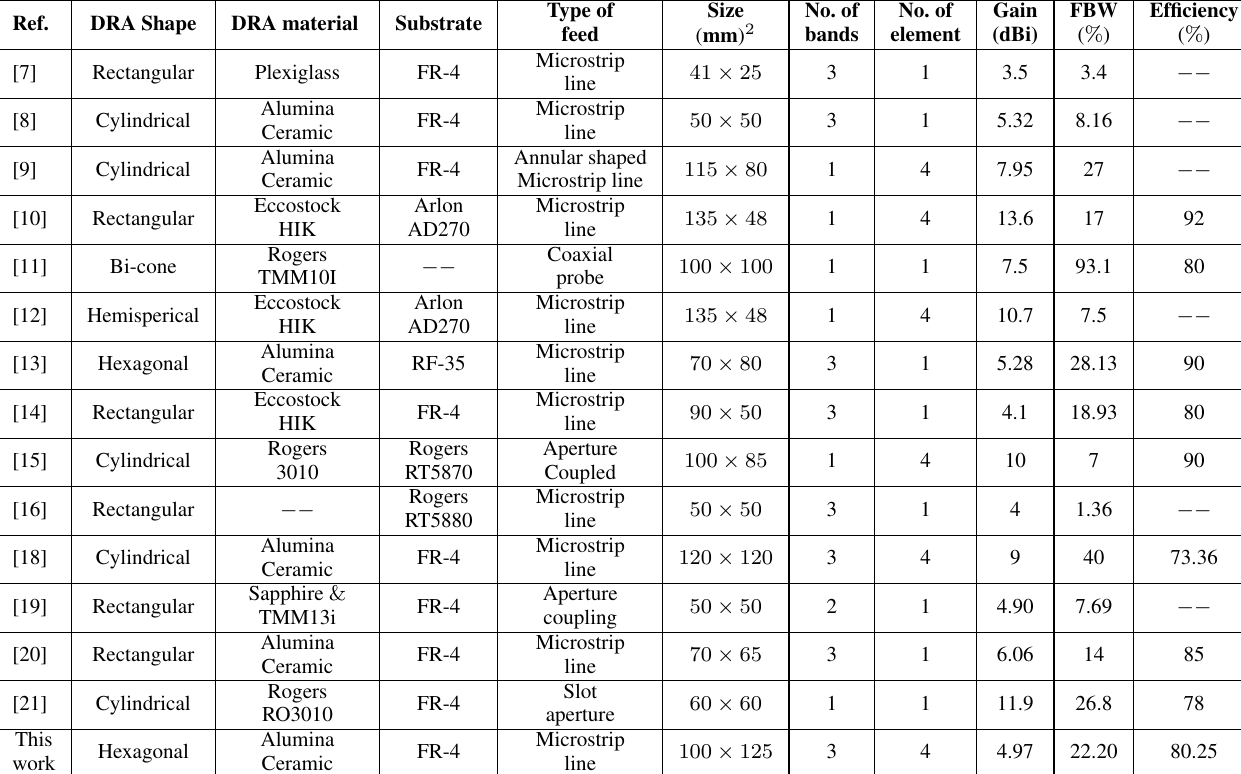
TABLE 4: Comparison with the state-of-art